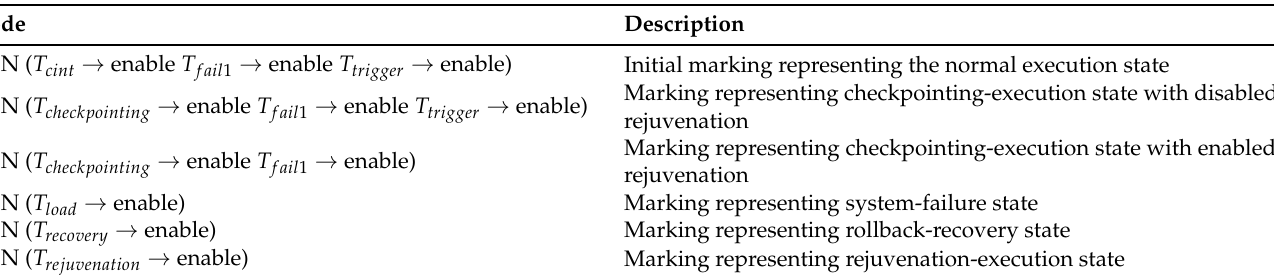
Table 2. Nodes in reachability